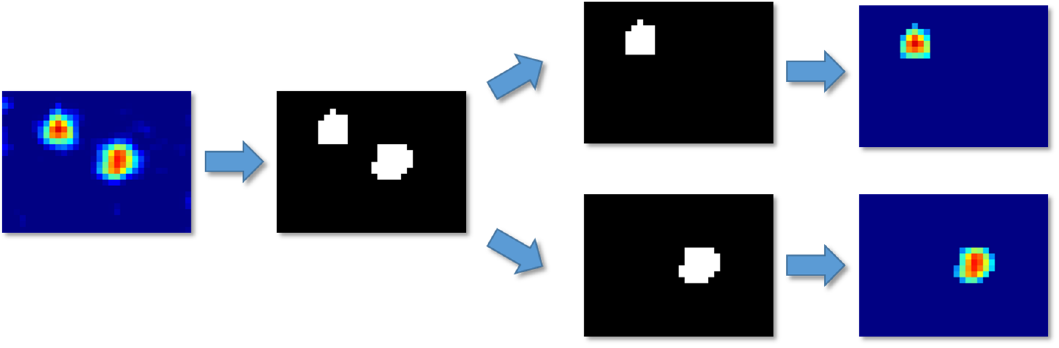
Figure 13. Multi-target detection.